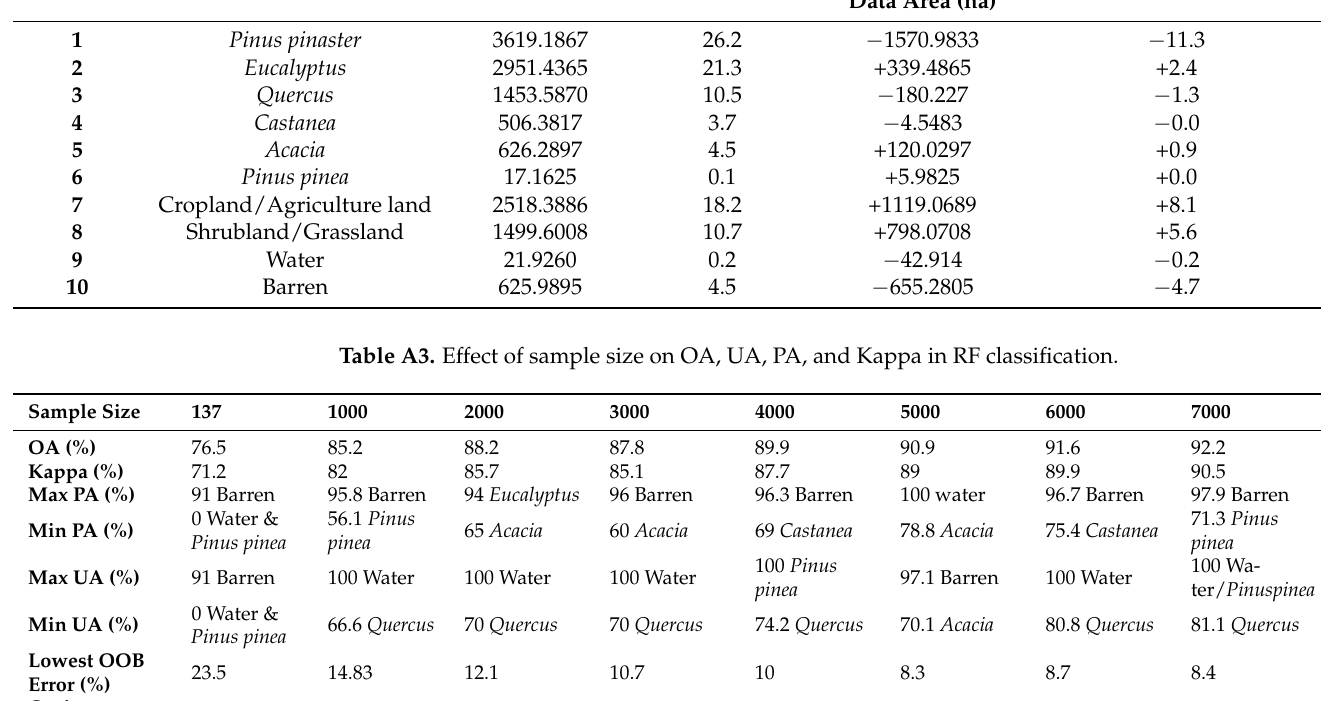
Figure A2. OOB Error of the number of RF mtry.